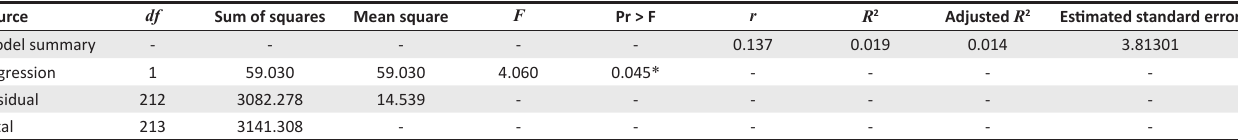
TABLE 3: Simple linear regression model fit and summary for work resources on employee physical health. Source df